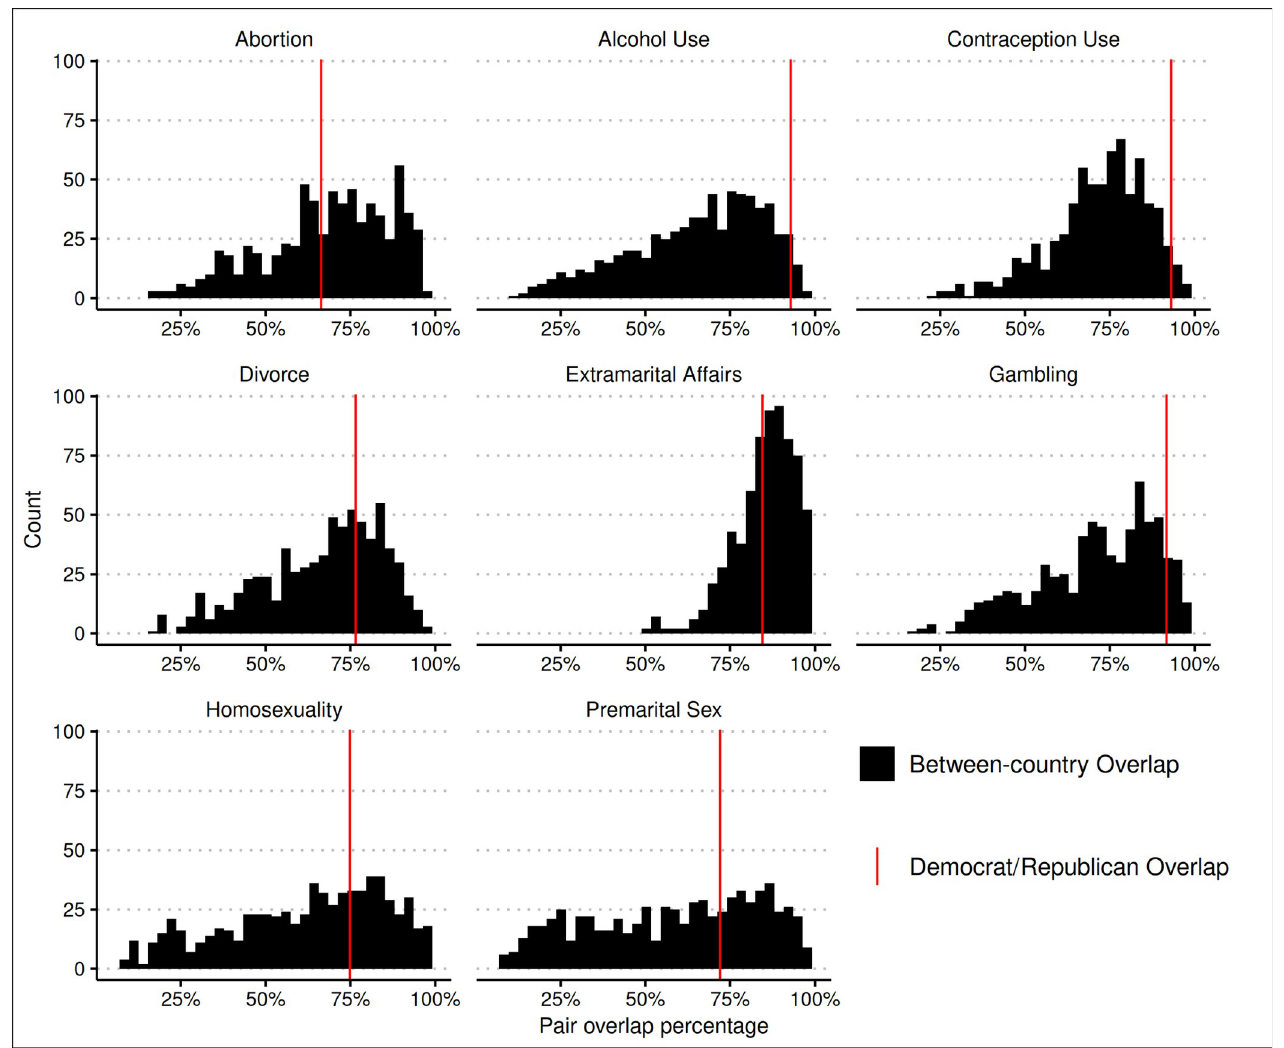
Fig 3. Distribution of all country pair overlap for moral issues. https://doi.org/10.1371/journal.pone.0231794.g003 Table 1. Overlap coefficients for moral issues. Democrat-Republican